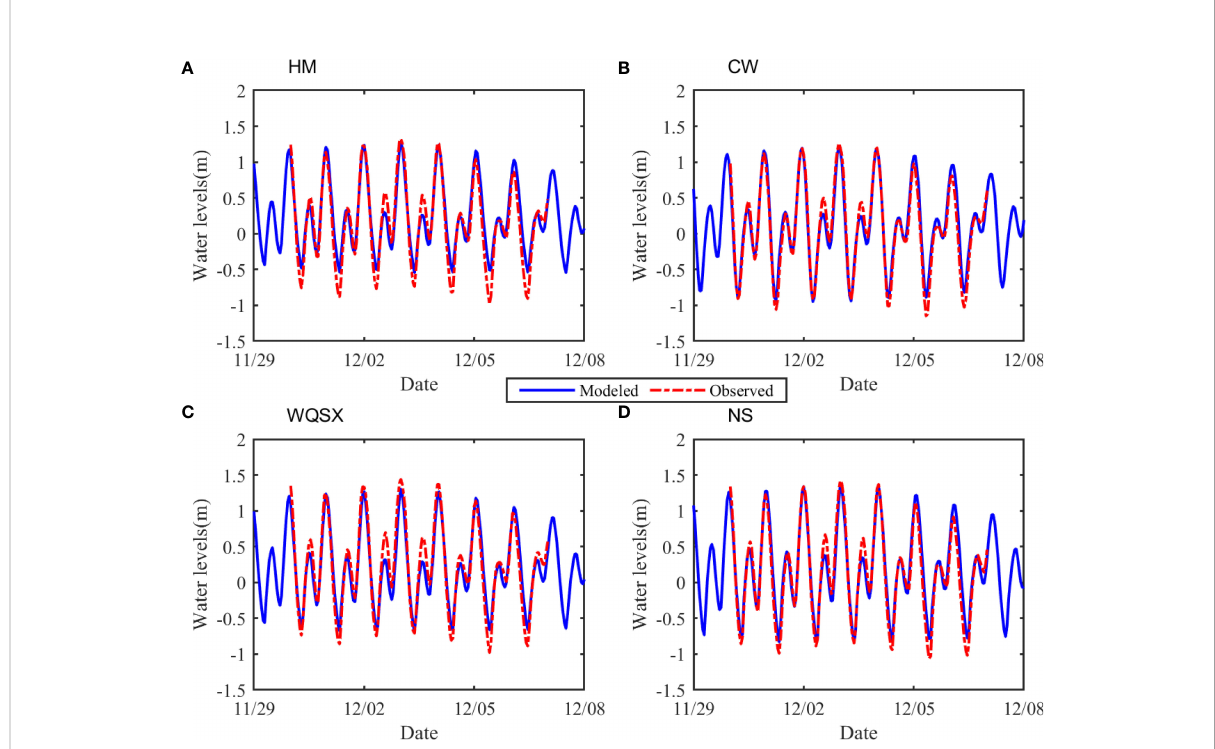
FIGURE 2 Model Calibration for water levels at tidal gauging station HM (A) , CW (B) , WQSX (C) , and NS (D) , where the blue lines represent modeled water levels and the red dashed lines represent the